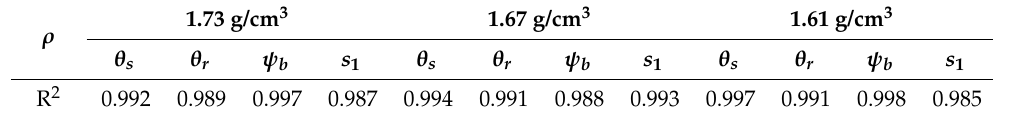
Table 4. Correlation coefficient of each